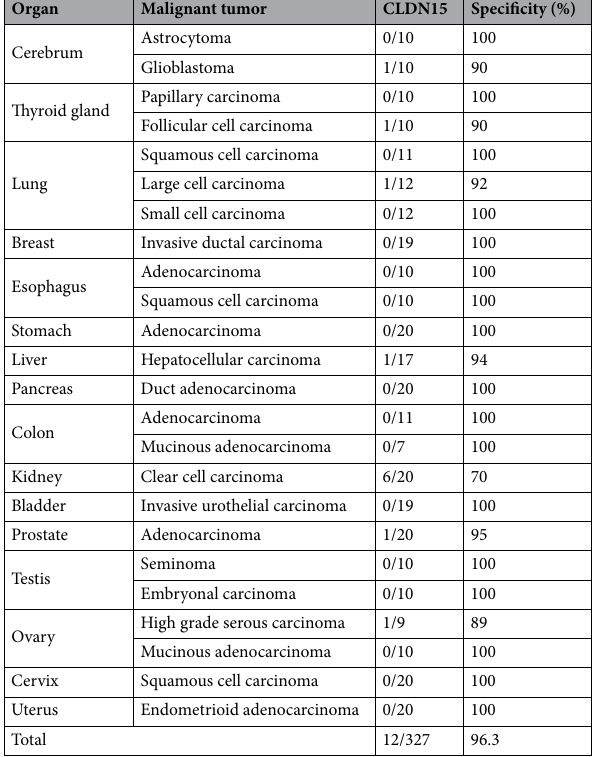
Table 3. CLDN15 expression in the tissue microarray of non MPM primary